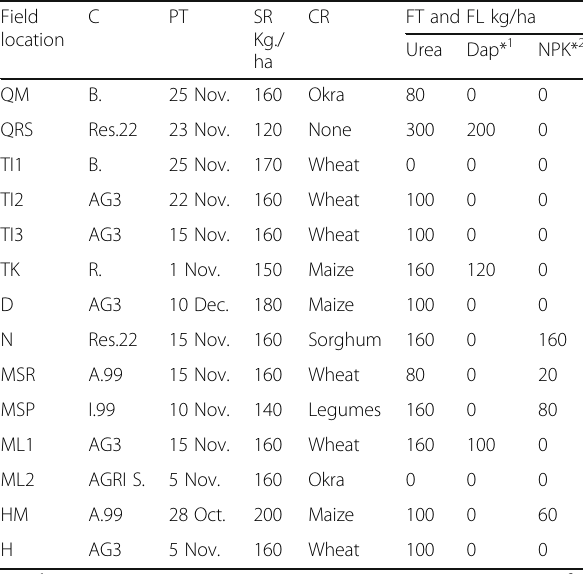
Statistical analysis Analysis of variance was executed using the statistical program SPSS® ver. 21.0 software (SPSS 2012) to deter-